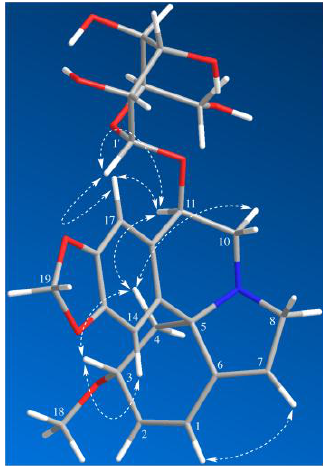
Figure 3. Key NOESY correlations of Compound 1 .